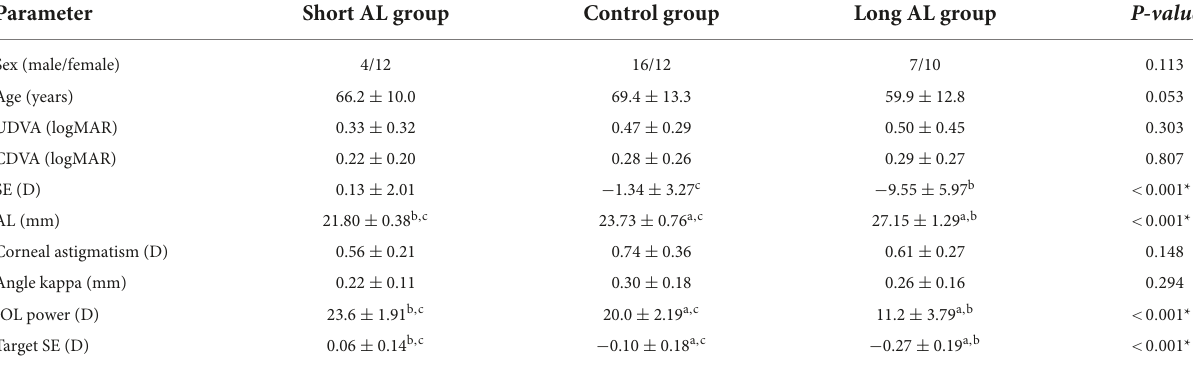
TABLE 1 Demographics and preoperative characteristics.